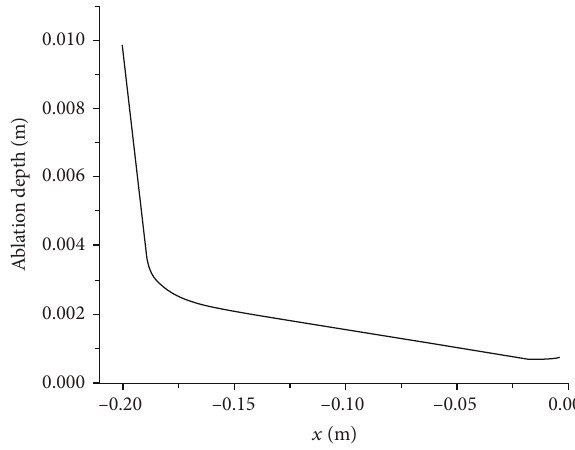
Figure 14: Recession depth distribution along the surface.